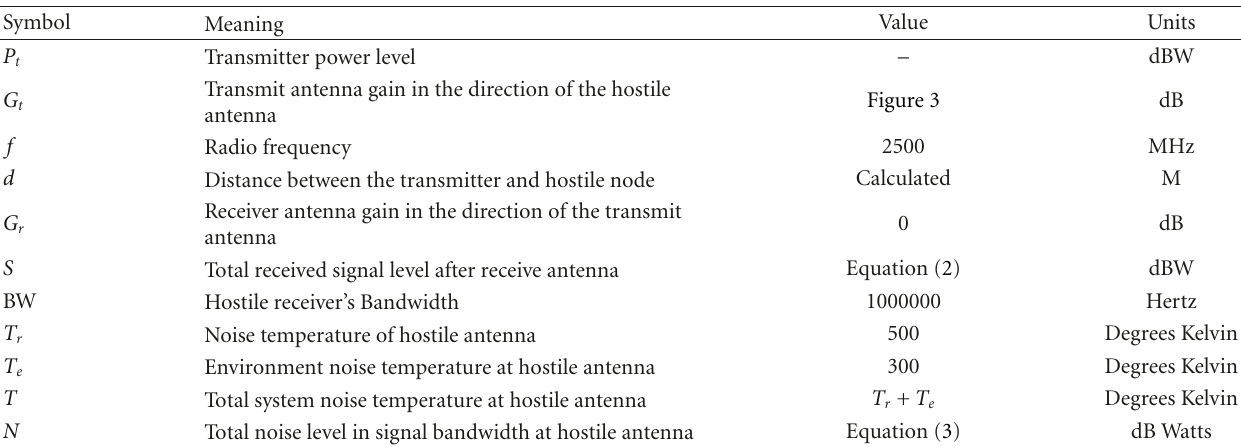
Table 1: Variable definitions for link budget equations.